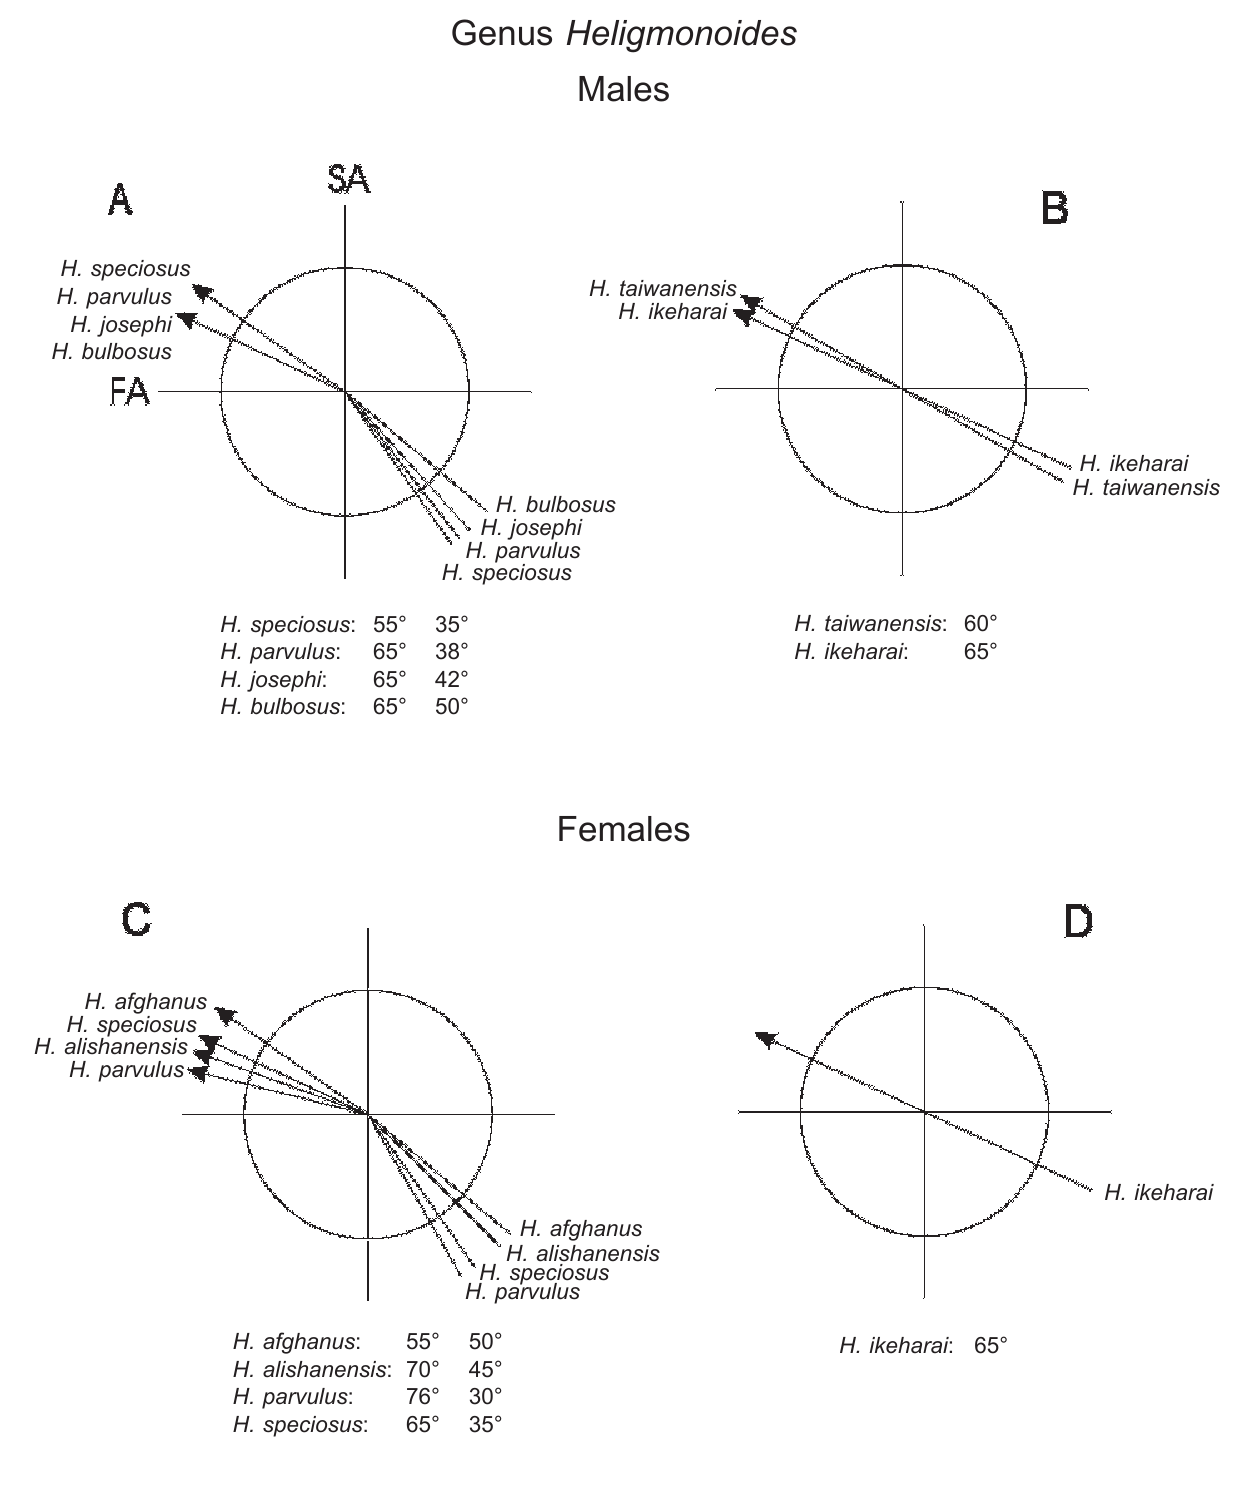
4. - Diagrams of the various degrees of inclination of the axes of orientation to the sagittal axis in the species of the genus Heligmo- noides Baylis, 1928 at mid-body. In the males, right axis inclined from 35° to 65° to the sagittal axis, left axis from 55° to 65° (A, B). In the females, right axis inclined from 30° to 65° to the sagittal axis, left axis from 55° to 76° (C, D). All the diagrams are orientated as D. The degree of inclination of the species (single axis or left axis/right axis) is listed under each dia- gram. Abbreviations: FA: frontal axis; SA: sagittal axis; l: left side; v: ventral